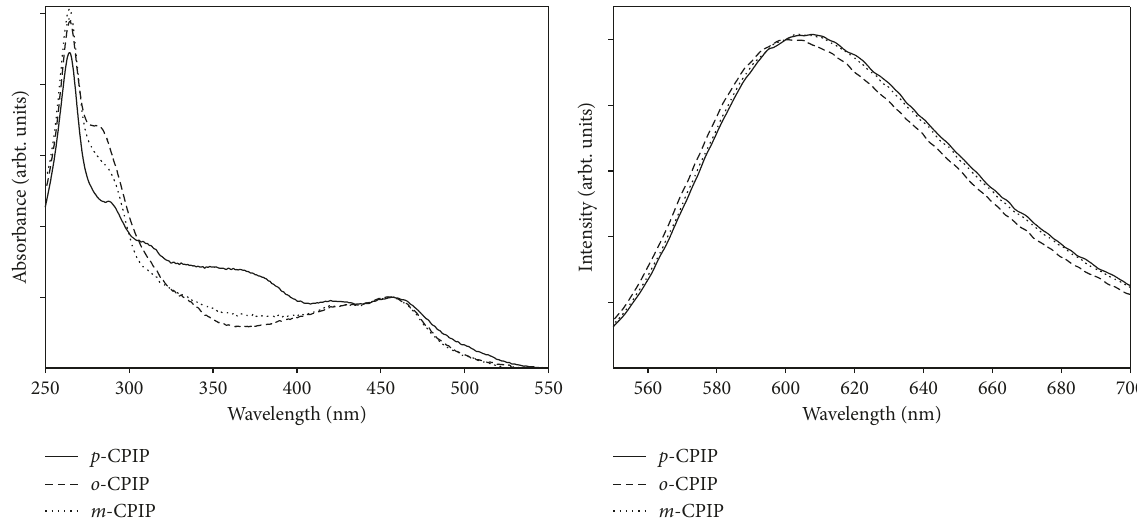
2+ , where L is m -CPIP, p -CPIP, and o -CPIP, 2 L]